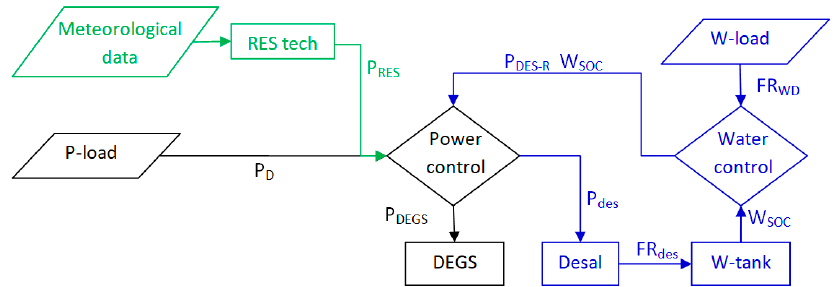
Figure 2. Model flowchart for base case (black section), renewable integrated configuration (green section) and desalination/renewable system (blue section).